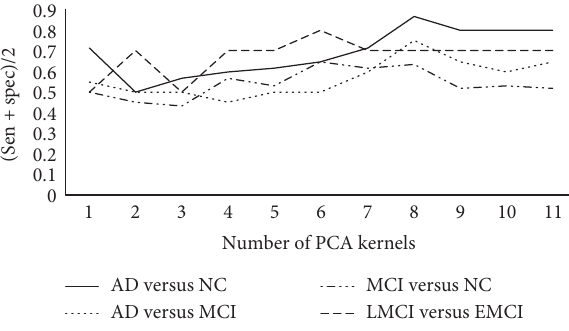
Figure 4: Accuracy of different PCA kernel